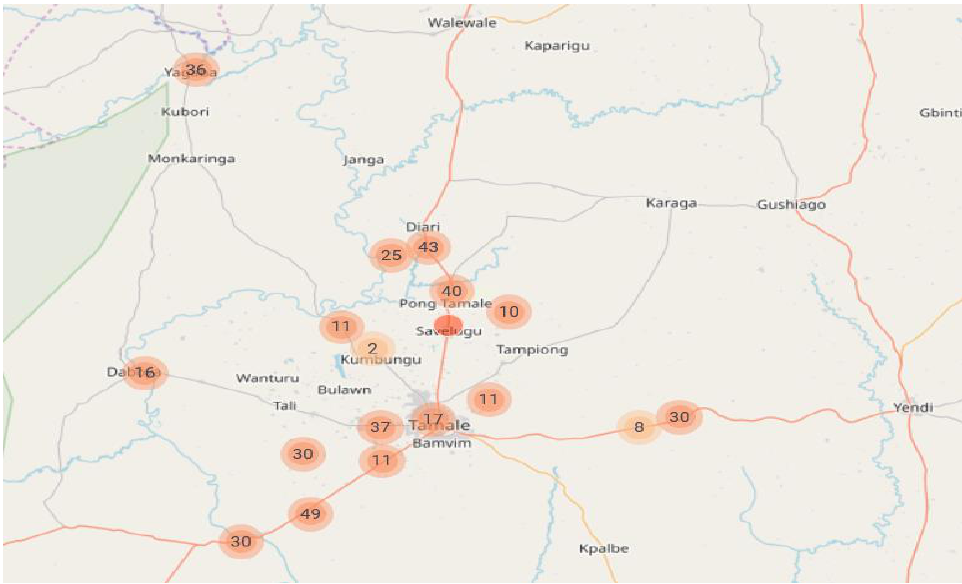
Figure 2. Overview of the study area. Note: The orange-colored circles represent the location of the respondent during the interview, while the figure in the orange-colored circles represent the number interviewed at that particular location. Source: Field Survey, 2018.